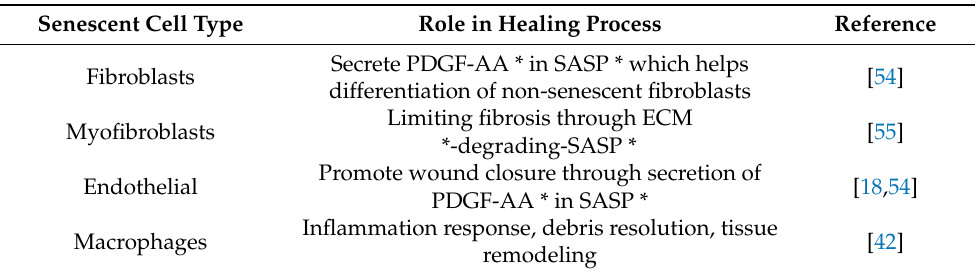
Table 1. Senescent cells present in acute cutaneous wounds listed alongside how they contribute to tissue